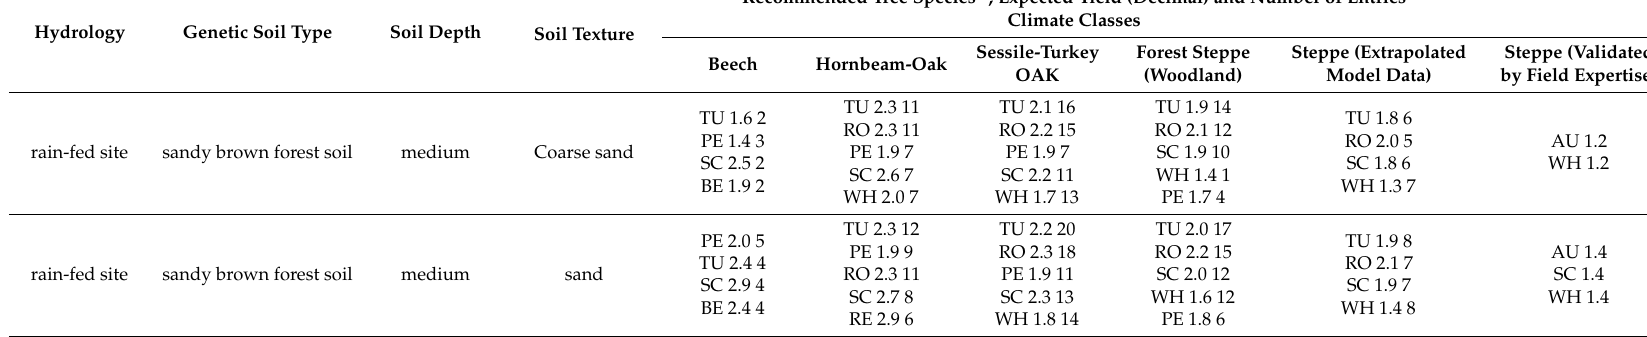
Table 2. Results of the machine learning-based analysis: Two sample rows of the spreadsheet differing only in soil texture, indicating recommended species and their estimated growth rate (first number), with number of analyzed entries (second number). Excerpt from the output of the machine learning method, validated by expert assessment. All data, except the field validations, are based on the Manual of Target Stands